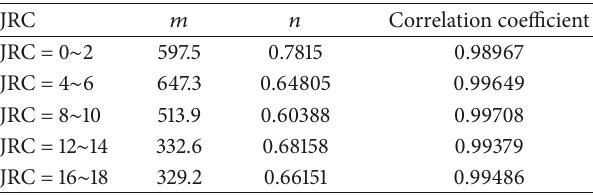
Table 1: Fitting analysis results of seepage velocity and hydraulic gradient of joints with different